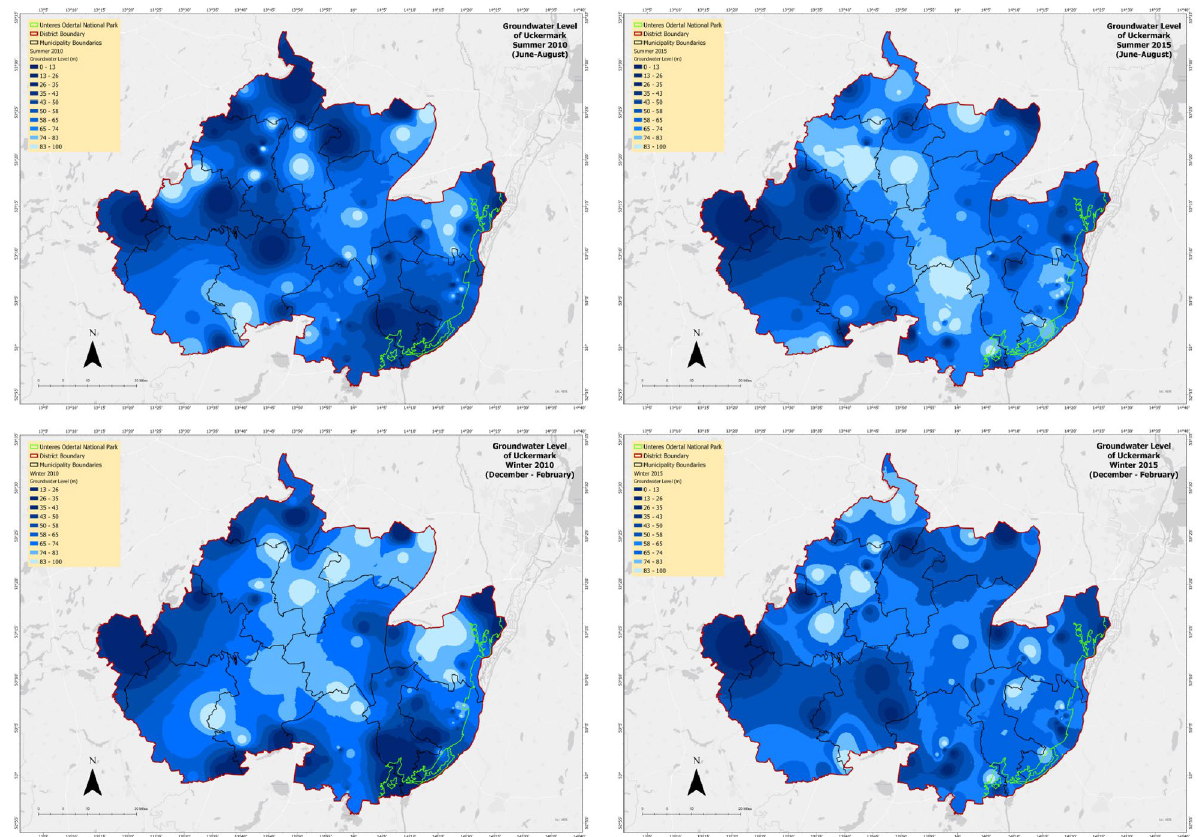
Figure 13. Groundwater level conditions of two seasons (2010, 2015) in Uckermark.